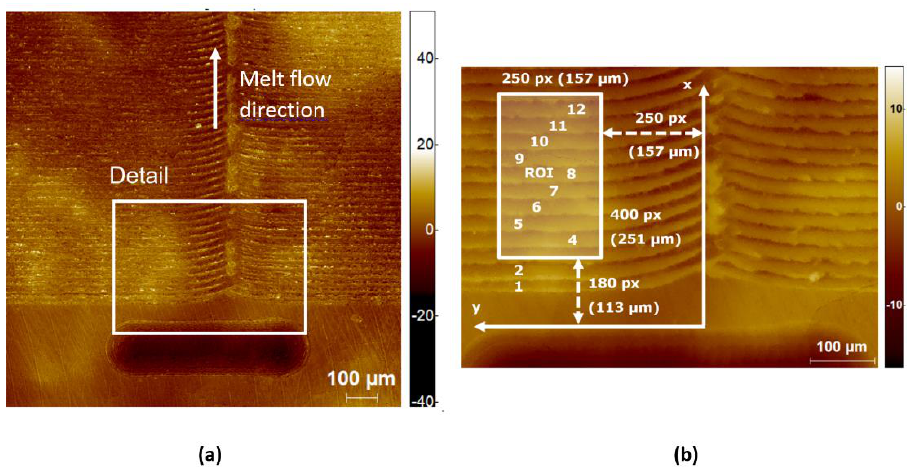
Figure 7. Corrected height map of QR code on mortar insert. ( a ) Overview, 10× magnification, 1278 µm × 1278 µm, 1024 pixels × 1024 pixels, z-scale in µm, z-range: 92 µm, height levelled by first-order polynomial; ( b ) Detail with region of interest, 20-fold magnification, 463 µm × 643 µm, 738 pixels × 1024 pixels, z-scale in µm, z-range: 31 µm, height levelled by first-order polynomial. The numbers 1 to 12 refer to different ripples.